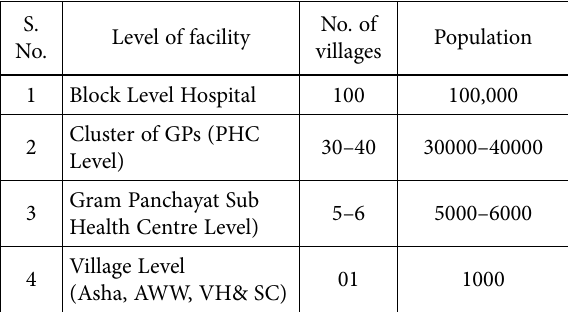
Table 1. Generic Public Health Delivery System